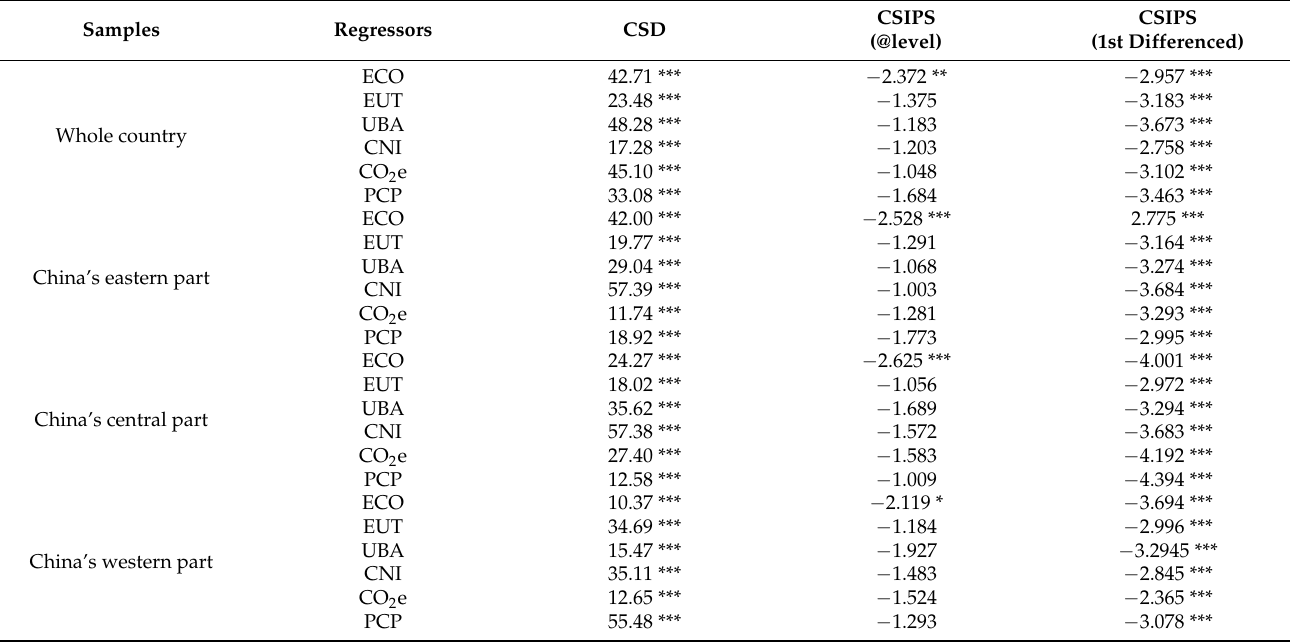
Table 2. Results of CSD and CSIPS testing approaches.